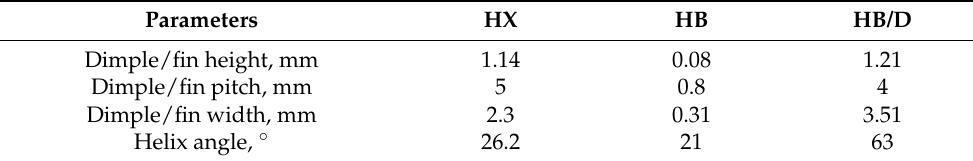
Table 1. Physical measurements of the enhancement patterns used in the various tubes.